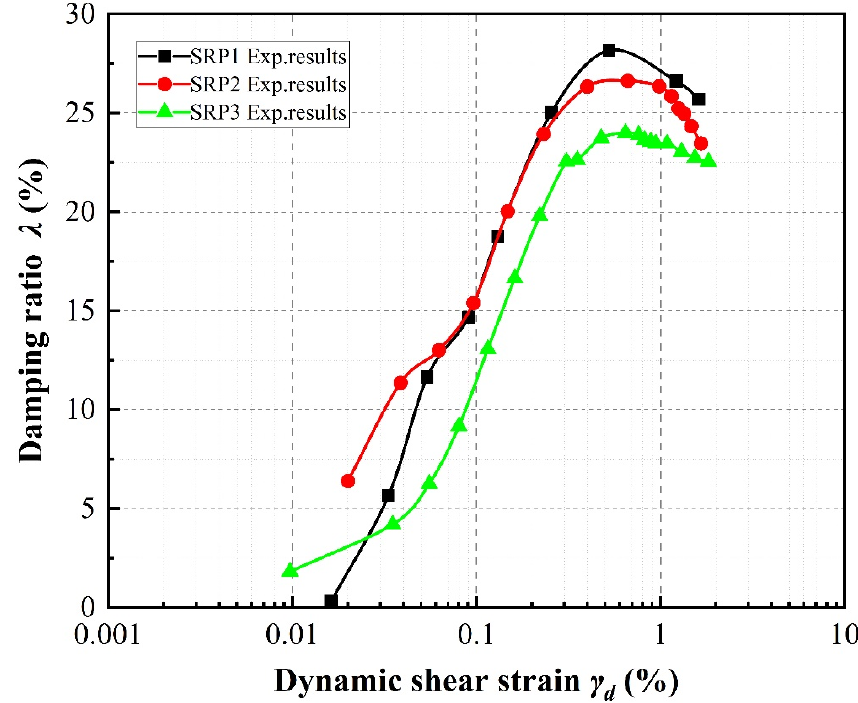
Figure 13. Effect of particle size on damping ratios of sand–rubber mixtures with 20% rubber content under 100 kPa confining pressure.